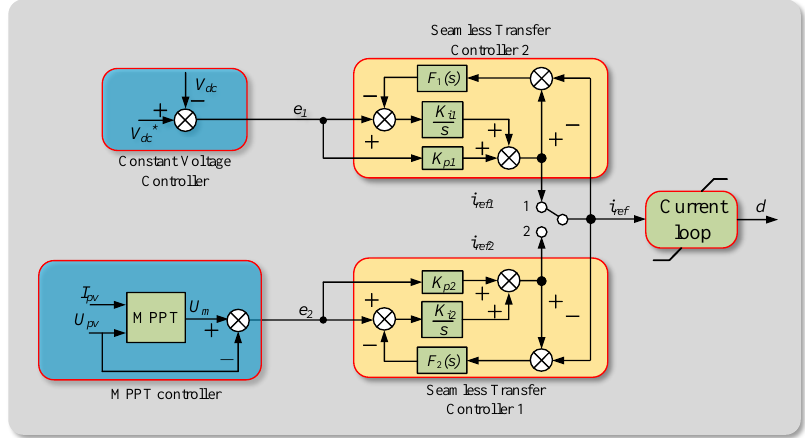
Figure 6. Controller for seamless transfer between voltage stabilization and MPPT operation of a PV generation unit.